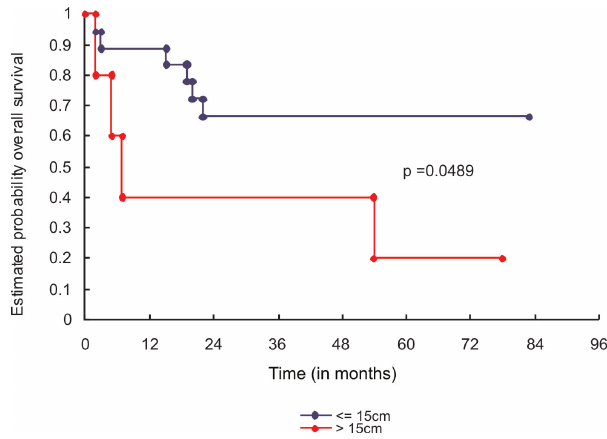
Figure 12 - Curve of overall survival in months for the 23 patients with primary osteosarcoma that was non-metastatic at diagnosis, according to tumor